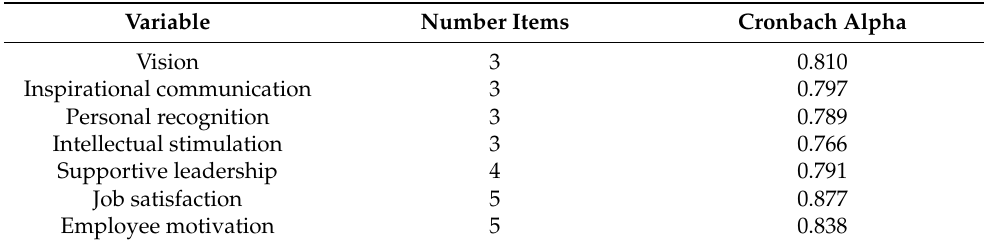
Table 3. Cronbach alpha